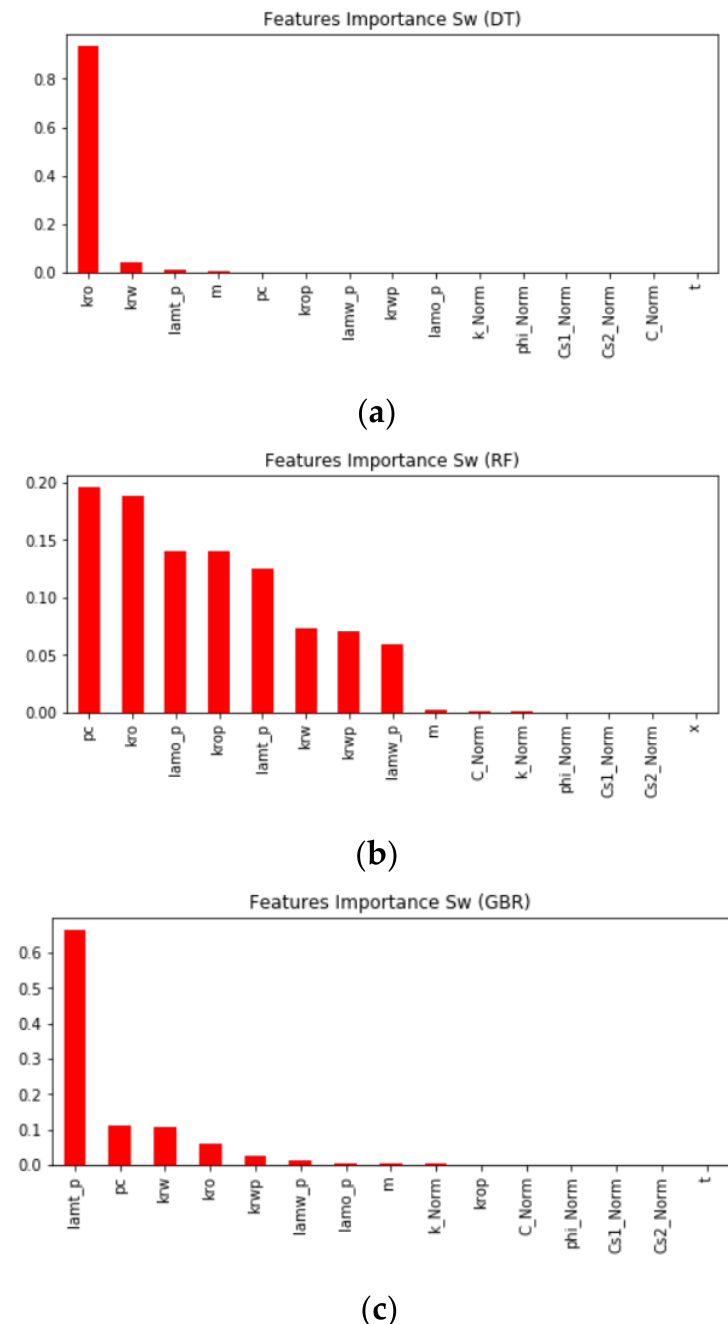
Figure 4. Features importance of ( a ) DT, ( b ) RF, and ( c ) GBR models for predicting S w . Figure 5 shows the actual values and the predicted values of S w for all four ML models. The four models have been graphed twice: one time without scaling the datasets and the other time with scaling the dataset using the StandardScaler. It can be seen that predicting S w when the dataset is not standardized had very close results to predicted values when the dataset became standardized, and the values in the figure are correlated. Except in the ANN model, which requires that the dataset standardize prior prediction. The ANN model with the tan h activation function had the highest correlated values in the scatter